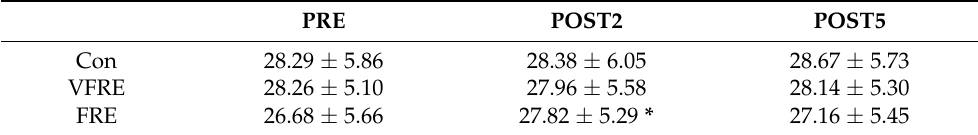
Table 1. The DJH of DJ (cm); mean ± SD †.